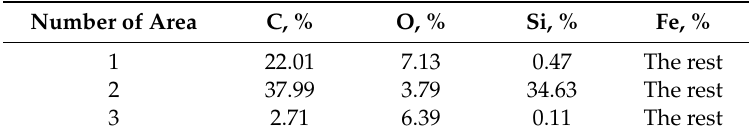
Table 7. The SEM analysis results of the FeGr1 + C+Al 2 O 3 + SiC mixture worn surface (Figure 16c, areas 1 – 3).